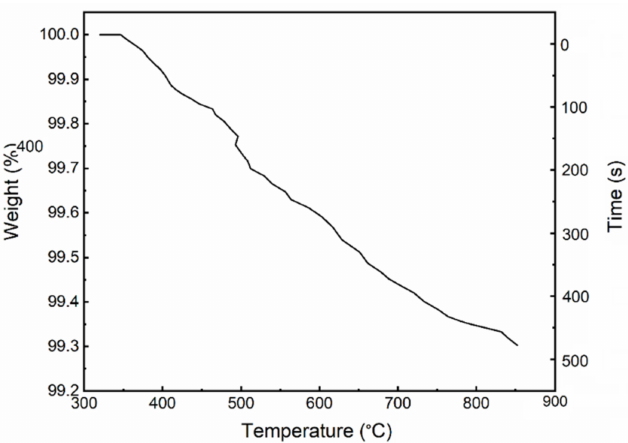
Figure 7. TGA result in TiH 2 embedded in formaldehyde resin.